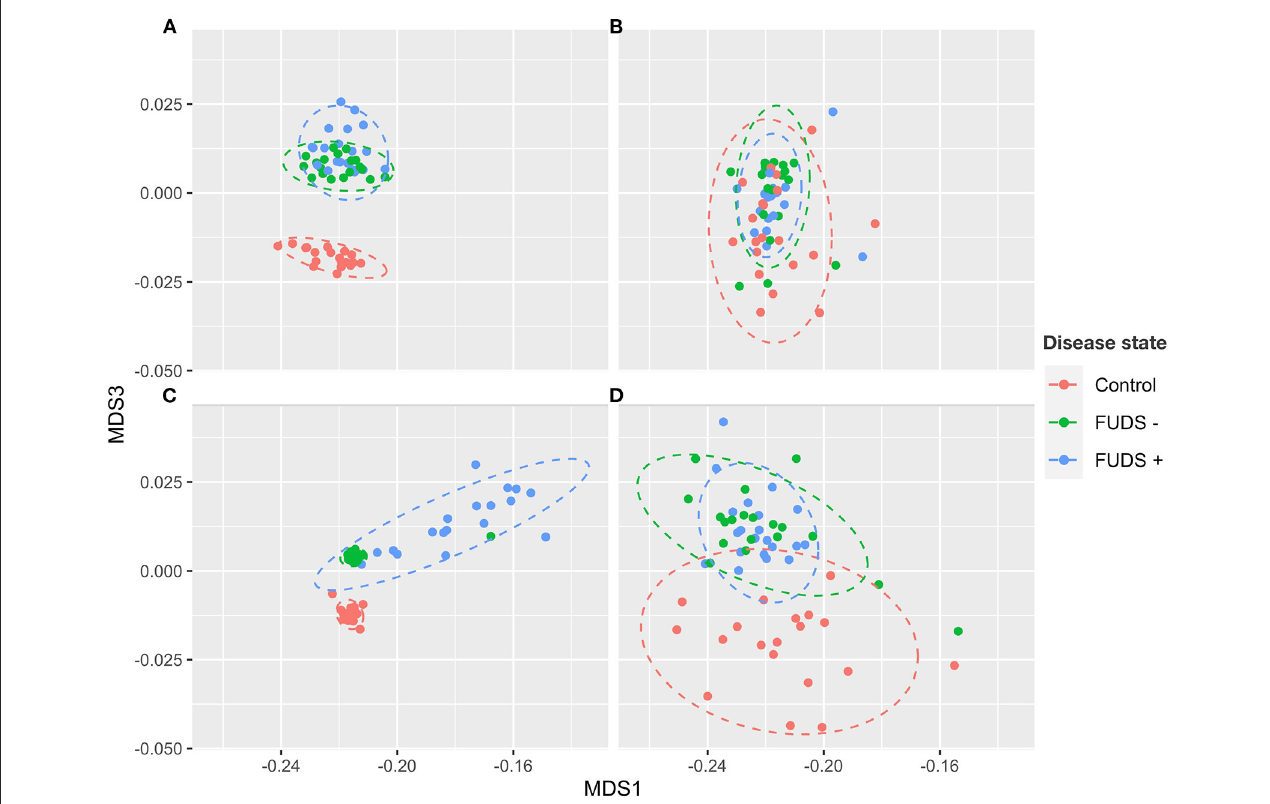
FIGURE2 Principal component analysis (PCoA) for Control, FUDS –, and FUDS + flocks by sample type. (A) Cecum; (B) ileum; (C) skin; and (D) cloaca. The plot was generated using the Bray-Curtis metrics.